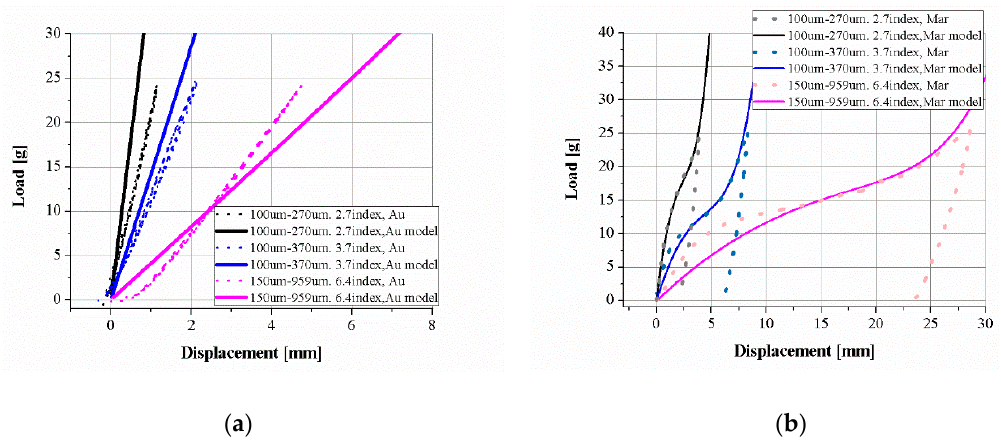
Figure 2. Comparison of experimental results with the static two-state model. Tensile test results and model plot of three kinds of SMA coil spring: ( a ) the austenite phase at high temperature and ( b ) the martensite phase at room temperature.